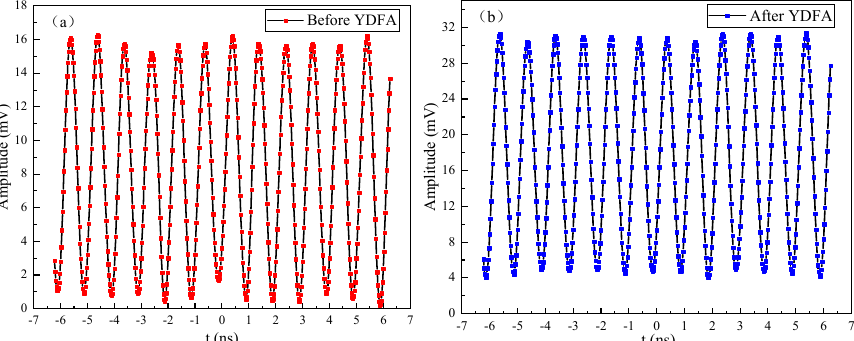
Figure 8. Modulation waveform ( a ) before and ( b ) after amplification.